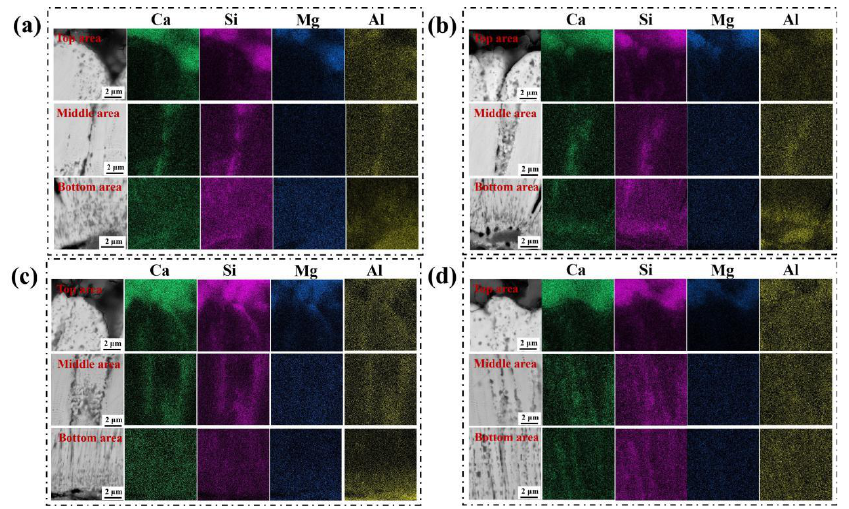
Figure 5. Cross-sectional morphologies of the top, middle, and bottom regions of the 7YSZ coatings deposited on four bond coats of different roughness: ( a ) as-prepared sample; ( b ) 100# sample; ( c ) 400# sample; ( d ) 1200# sample.